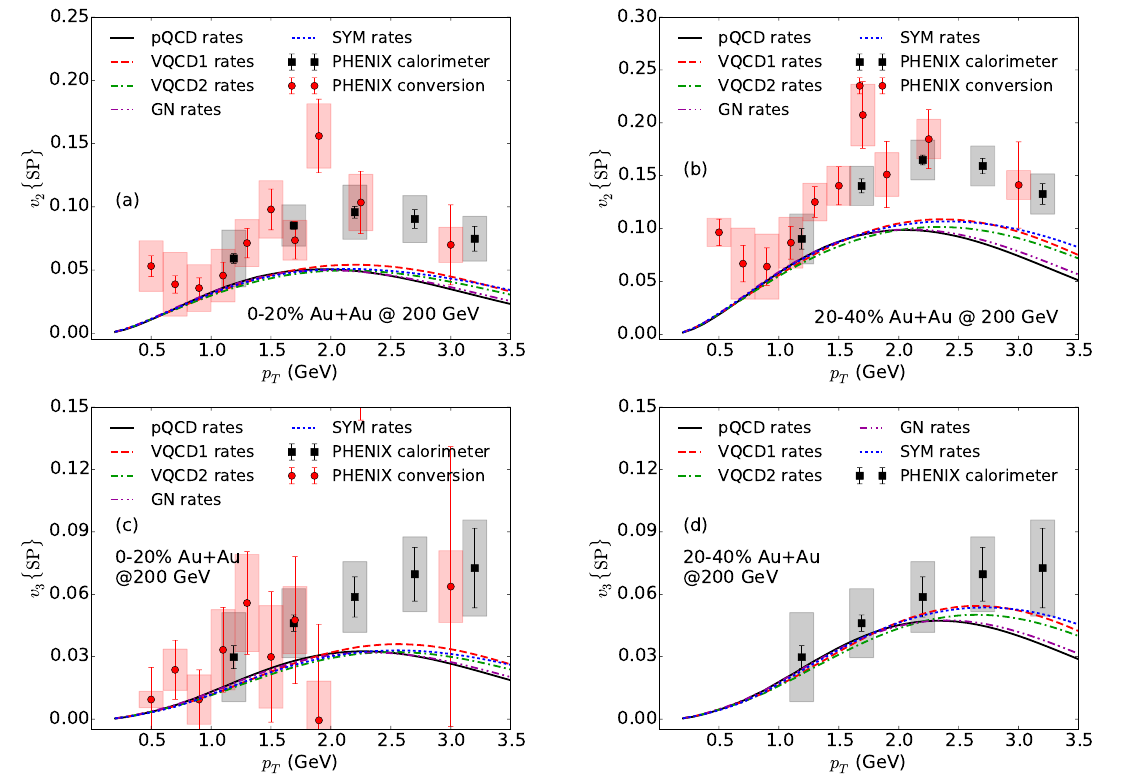
Figure 5 . (Color online) Direct photon anisotropic (cid:13)ow v 2 ; 3 from 0{20% (a,c) and 20{40% (b,d) Au+Au collisions at 200 GeV compared with the PHENIX measurements [98].